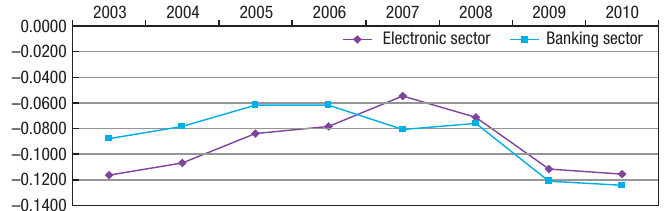
Fig. 3. Sector CoVaR of electronic sector and banking sector during